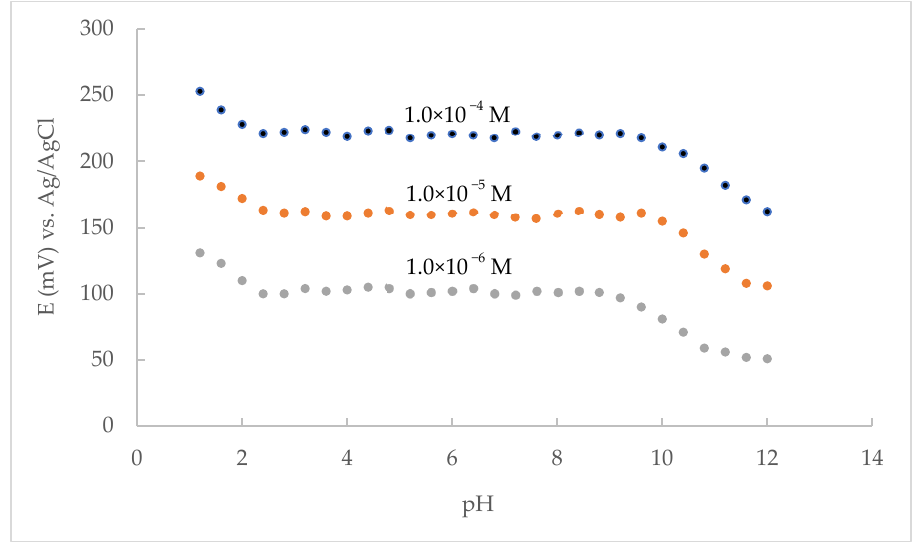
Figure 3. Effect of the pH on the electrode response characteristics.